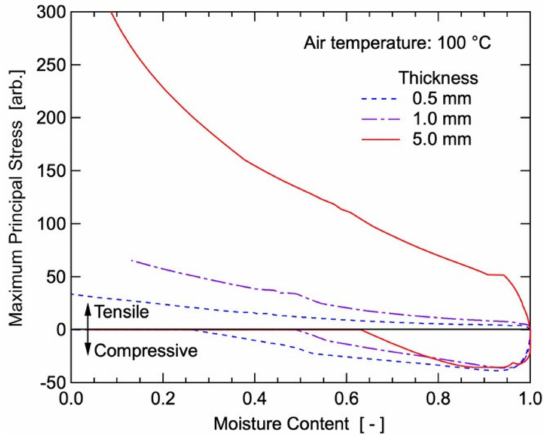
Figure 12. Maximum principal stresses against moisture content in sample with di ff erent